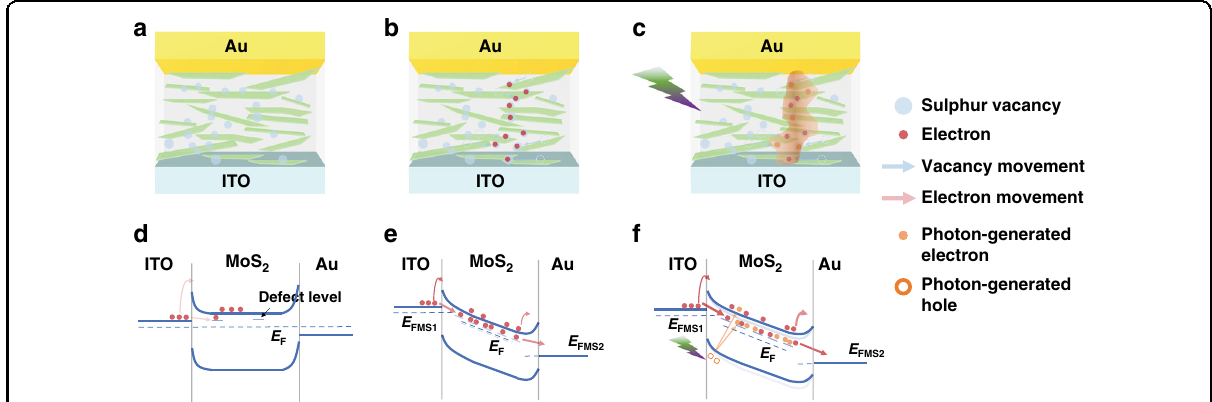
Fig. 3 Mechanism of Opto-Resistive RAM Switch. a – c The conducing states in the Opto-Resistive RAM Switch at ( a ) initial state, b SET process without optical input, and ( c ) SET process with optical input. d – f Corresponding energy band diagram of Opto-Resistive RAM Switch at ( d ) initial state, e SET process without optical input, and ( f ) SET process with optical